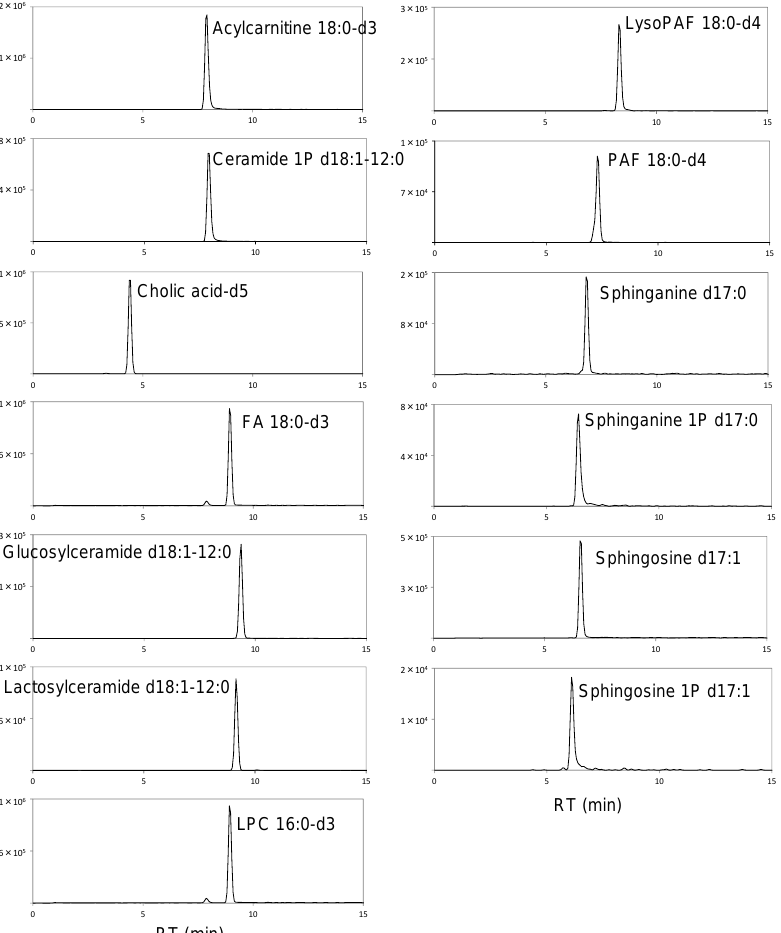
Figure 1. Chromatograms of the 13 compounds used for IS. X- and Y-axes indicate the retention time (RT; min) and intensity, respectively.